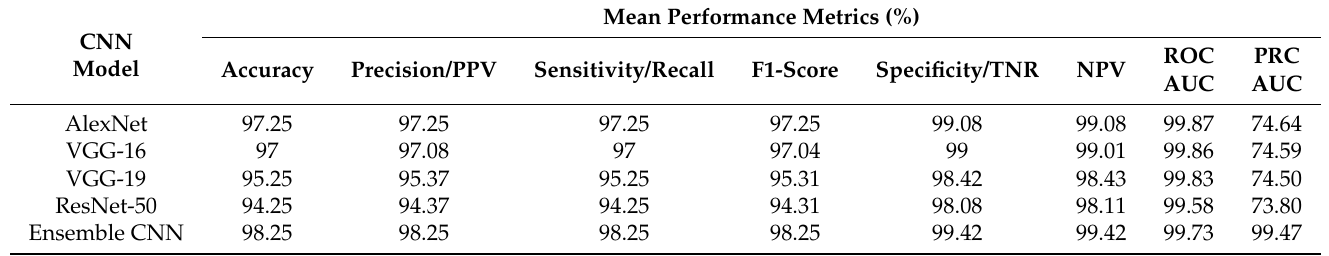
Table 3. Comparison of classification testing results.